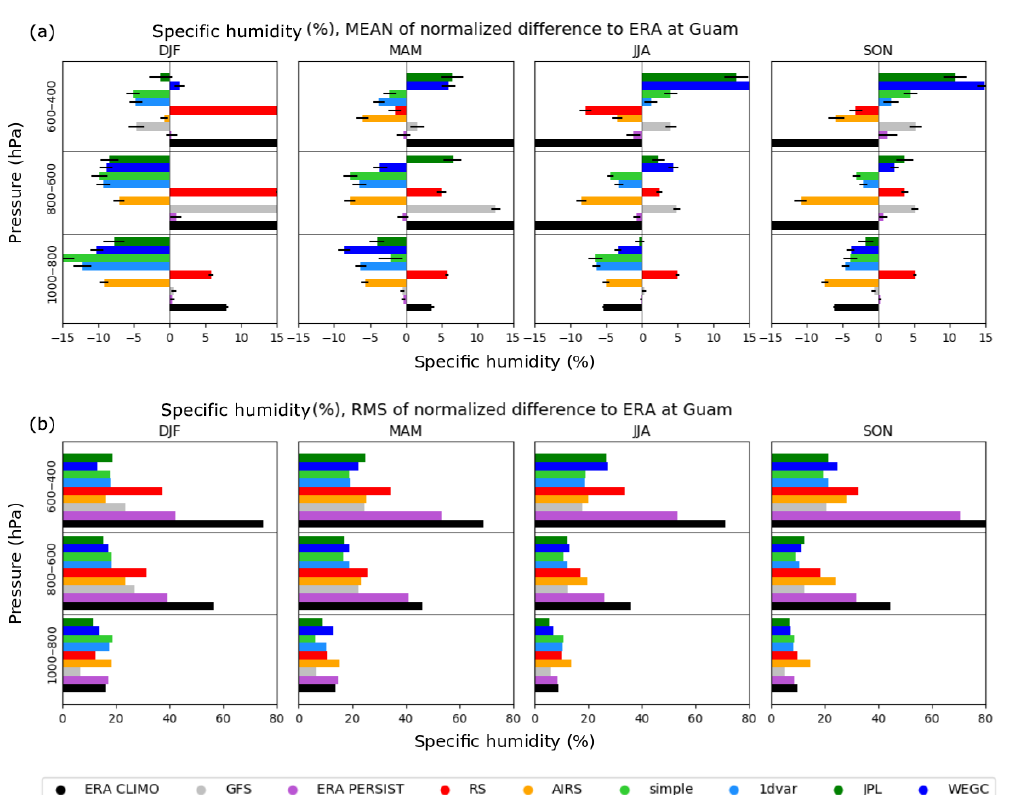
Figure 6. Guam: The mean (a) and rms (b) of the q normalized difference for all data sets, three pressure layers, and four seasons. Data sets from top to bottom (per pressure layer): JPL direct, WEGC 1D-Var, UCAR direct, UCAR 1D-Var, RS, AIRS, GFS, PERSIST,